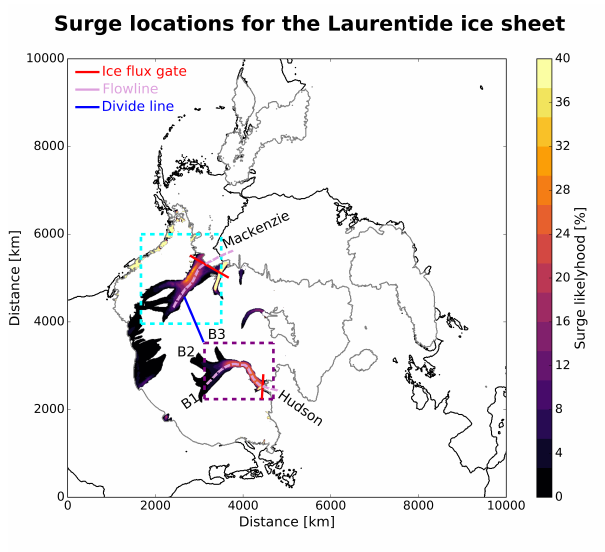
Figure 1. Overview of the northern hemispheric ice-sheet model domain, highlighting surge regions from the Laurentide ice sheet. Surge likelihood is calculated from the Ctrl simulation and is the percentage of time that the ice velocity in each cell exceeds 2000myr − 1 . Dashed cyan and purple boxes show areas used for ice volume calculations for Mackenzie and Hudson ice stream, re- spectively. Pink lines are flowline locations shown in Figs. 4 and 6. Red lines show flux gates across which ice flux for the respective ice stream is calculated. The solid blue line is approximately perpen- dicular to the drainage basin divide between Hudson and Macken- zie drainage basins. Labels B1, B2, and B3 depict different surge branches of the Hudson ice